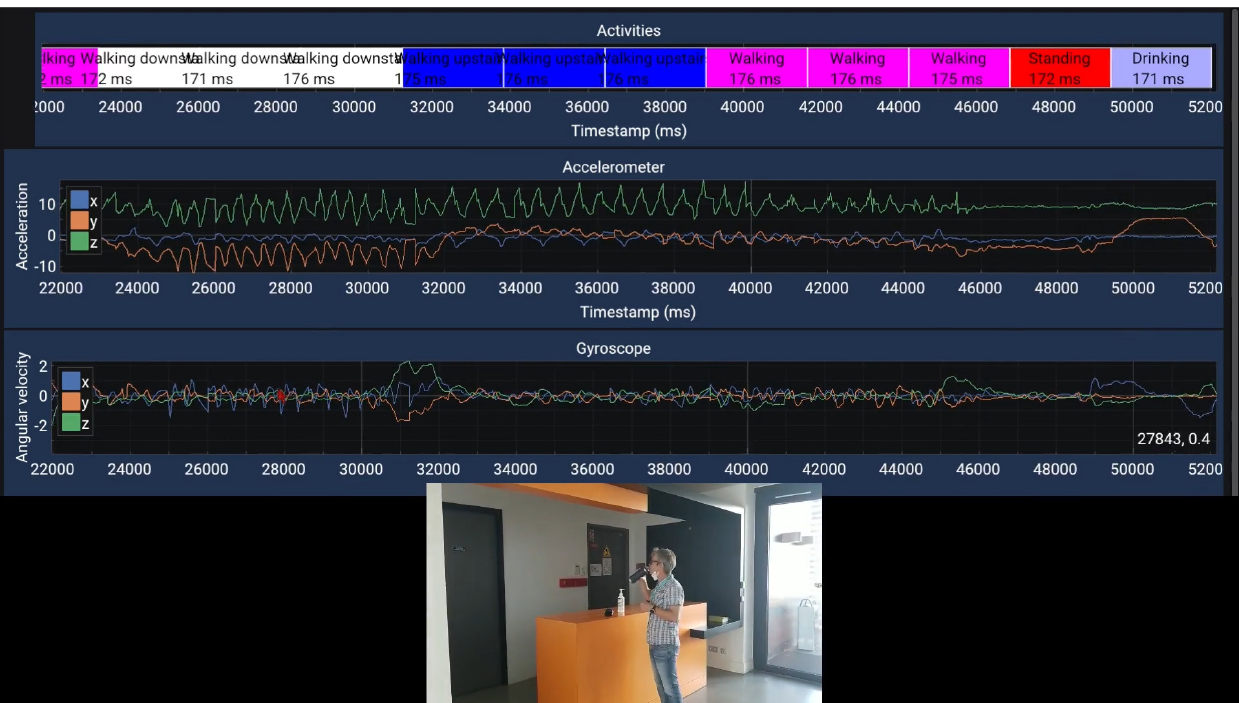
Figure 10. Live human activity recognition on